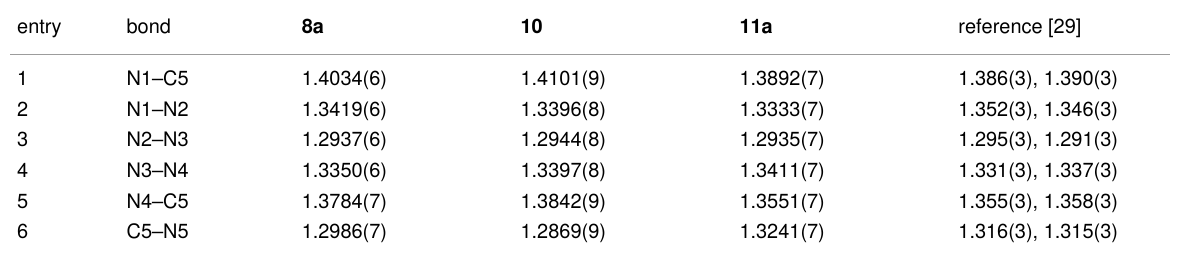
Table 2: The lengths of the tetrazole ring and exocyclic C–N bonds (Å) in compounds 8a , 10 , and 11a , and in the 1,3-di- tert -butyltetrazolium-5- aminide ligand in manganese complexes [29].